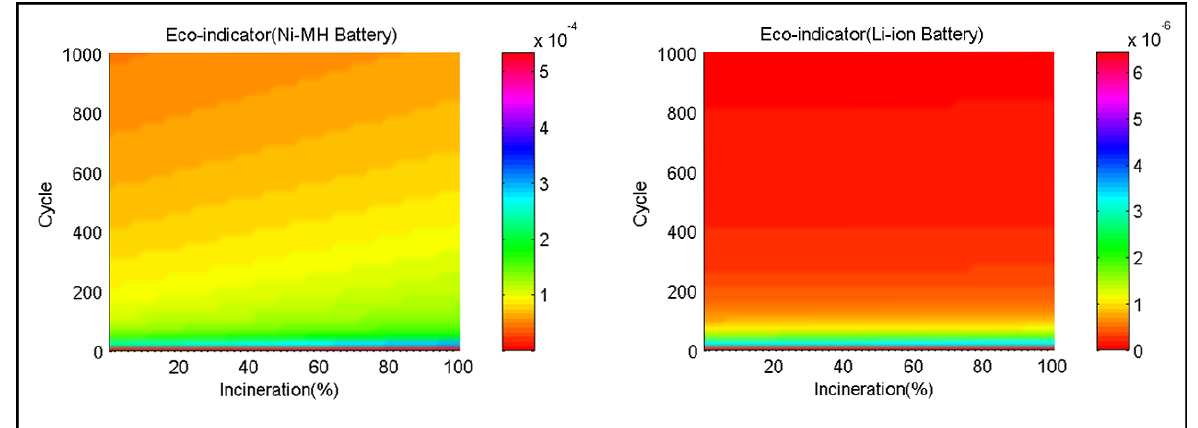
Figure 5. Influence of cycles and incineration rate on the Eco-indicator of the two selected